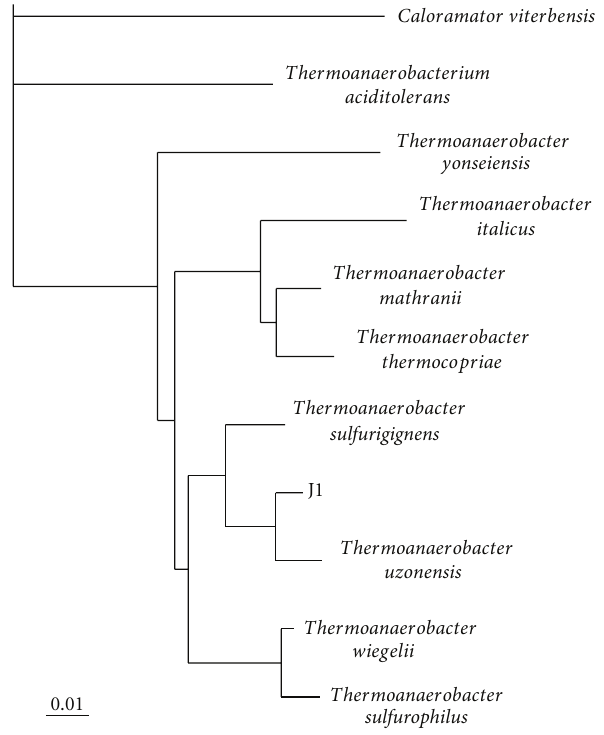
Figure 1: Phylogeny of strain J1 based on partial 16S rRNA se- quence analysis. The phylogenetic tree was generated by using dis- tance matrix and neighbor-joining algorithms. Caloramator viter- bensis was selected as outgroup. The bar indicates 0.01 substitutions per nucleotide position.